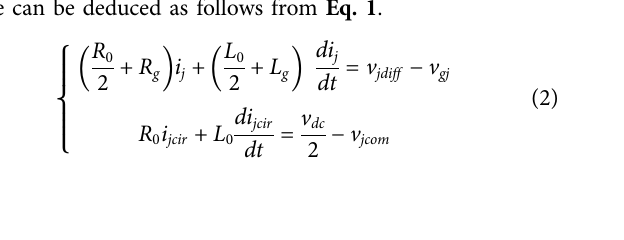
The differential- and common-mode voltages and currents mentioned in Eq. 2 are de fi ned as follows.